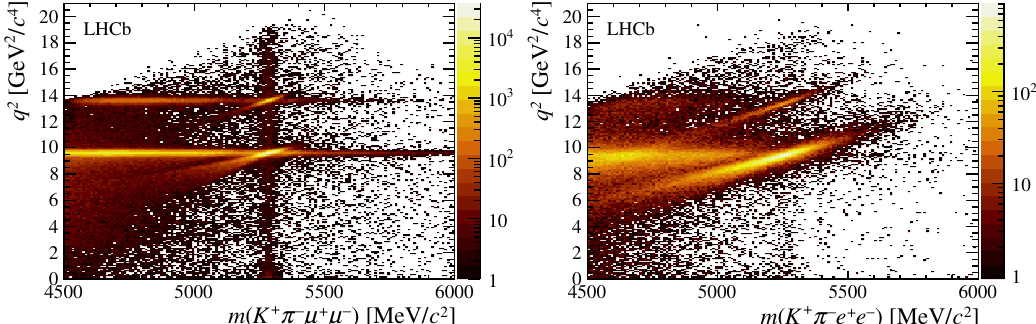
Figure 2 . Number of candidates for B 0 ! K (cid:3) 0 ‘ + ‘ (cid:0) (cid:12)nal states with (left) muons and (right) electrons as a function of the dilepton invariant mass squared, q 2 , and the four-body invariant mass of the B 0